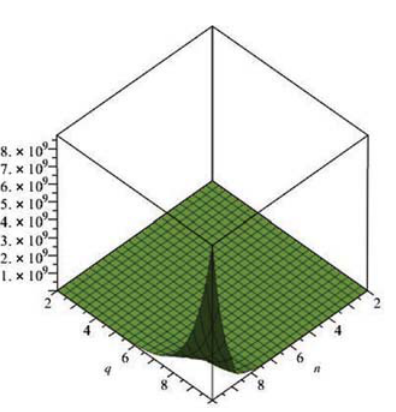
Figure 6: Plot of ξ sv . Figure 9: Plot of M